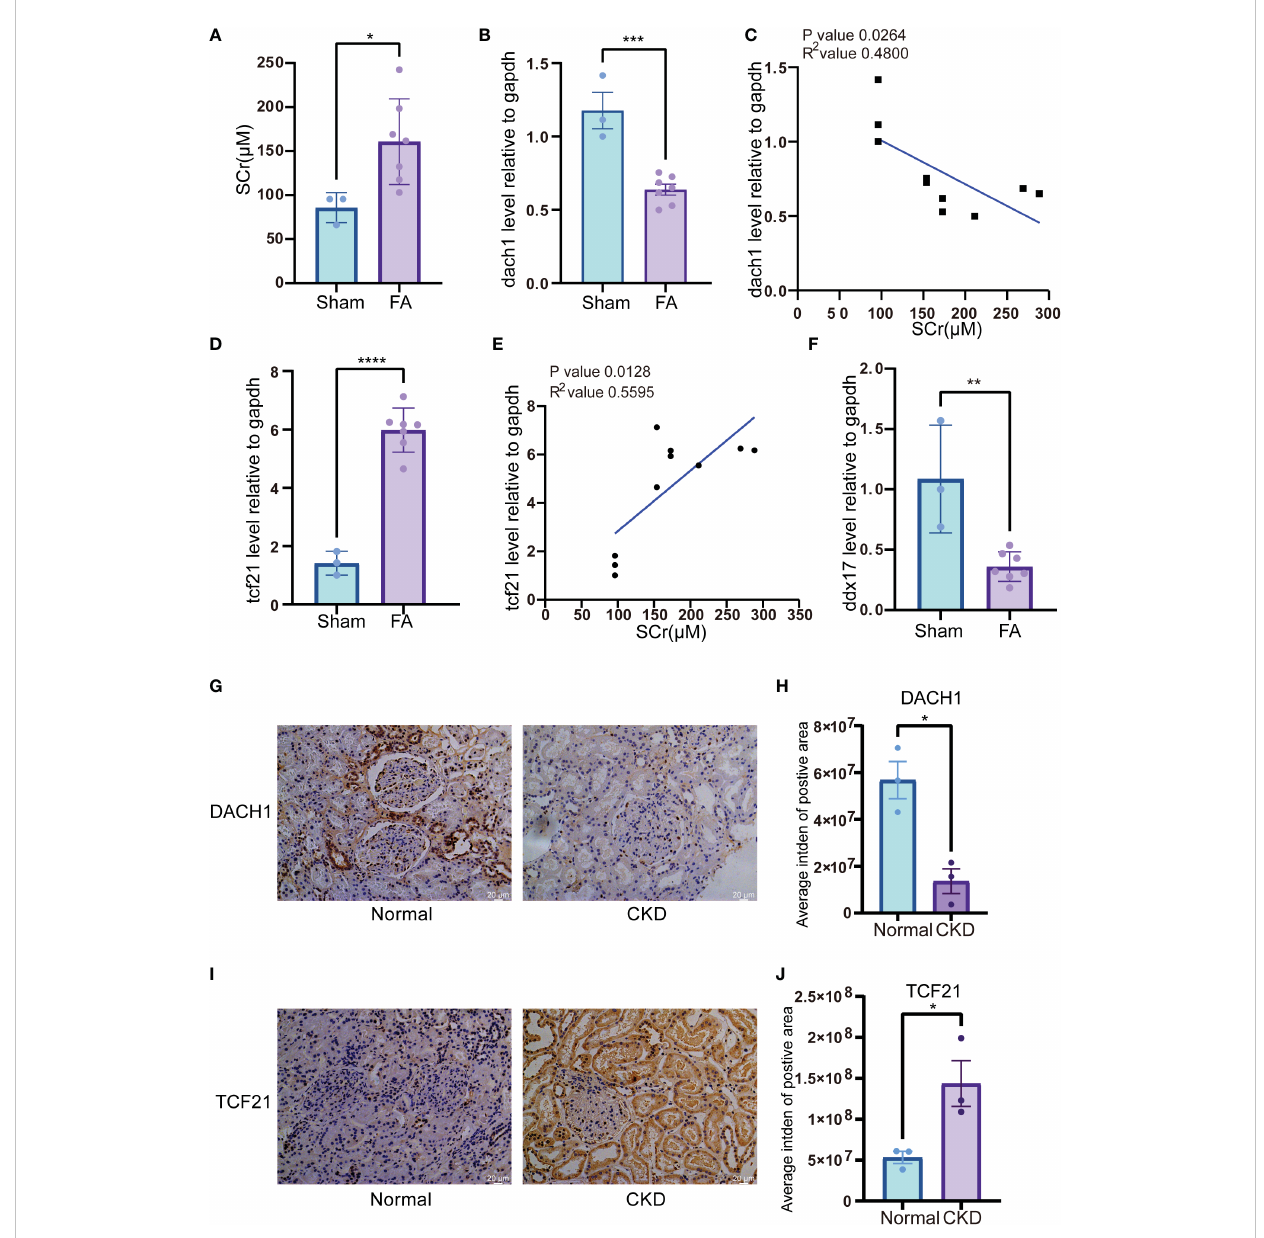
FIGURE 9 Expression of genetic biomarkers in folic acid (FA)-induced CKD murine model and membranous nephropathy (MN) patient ’ s biopsy (A) SCr level in FA-induced CKD murine model. Blood serum was harvested 3 days after FA injection. (B) mRNA level of dach1 in kidneys from FA-induced CKD murine model. (C) Correlation between dach1 mRNA level in kidney tissue and SCr from FA-induced CKD murine model. (D) mRNA level of tcf21 in kidney tissues from FA-induced CKD murine model. (E) Correlation between tcf21 mRNA level in kidney tissues and SCr from FA-induced CKD murine model. (F) mRNA level of ddx17 in PBMC from FA-induced CKD murine model. (G) IHC staining of DACH1 in normal kidney tissues and CKD tissues. The representative pictures of CKD were from the membranous nephropathy (MN) patient ’ s biopsy. (H) Quantitative results of DACH1 expression in panel (G) . The expression level was calculated by average integrated density (Intden) of positive area. (I) IHC staining of TCF21 in normal kidney tissues and CKD tissues. (J) Quantitative results of TCF21 expression in (I) . * P < 0.05; ** P < 0.01; *** P < 0.001; **** P <